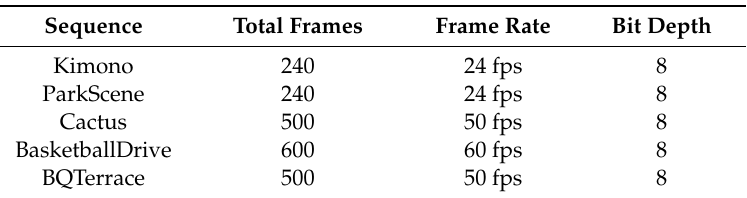
Table 4. Test sequence information [22].